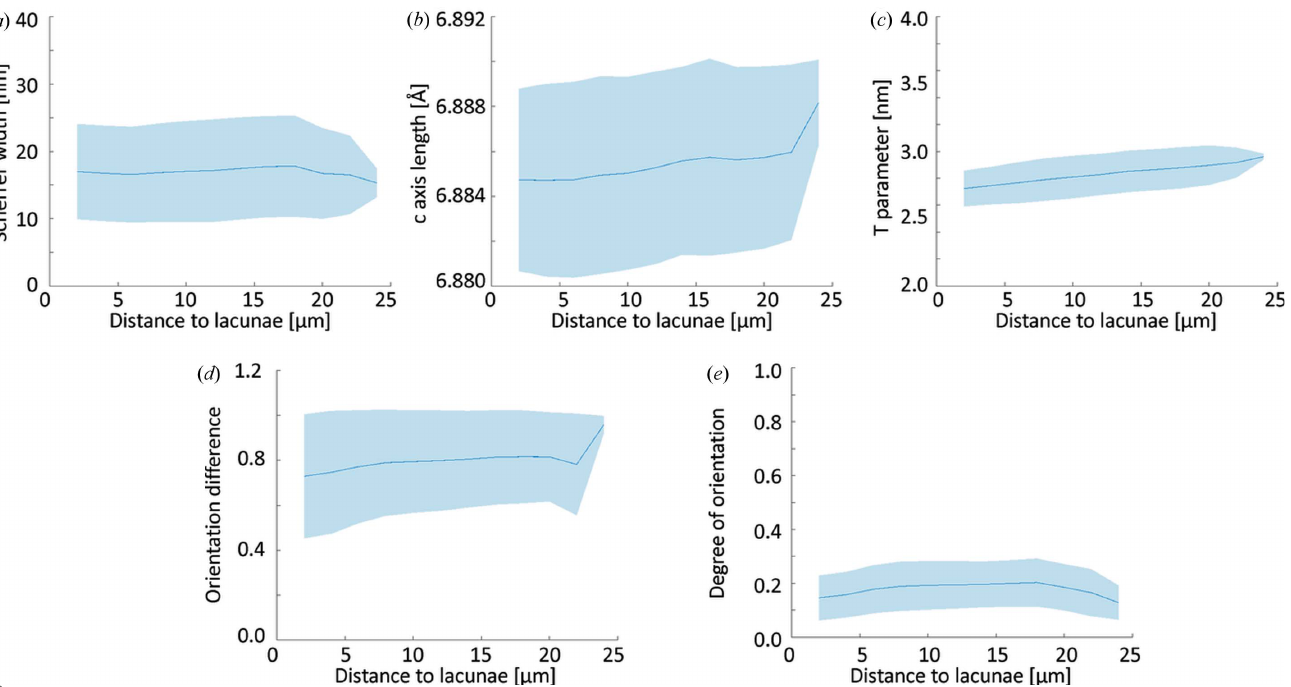
Figure 4 Nanostructural and crystallographic parameters plotted against the distance to the nearest lacunae as determined by SAXS/WAXS-CT [panels ( a )–( c )] and SAXS/WAXS-TT [panels ( d ) and ( e )]. ( a ) Apparent crystallite size (Scherrer width). ( b ) Length of the HAP c axis. ( c ) T parameter of the mineral particles. ( d ) Squared dot product of the SAXS and WAXS tensors. ( e ) Degree of orientation determined by